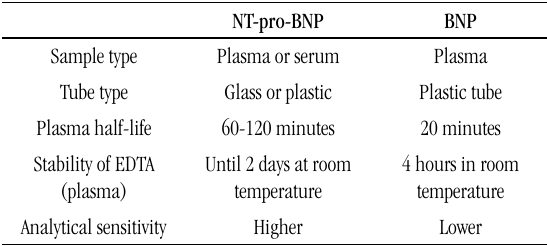
tABLE 3 – Information on essays